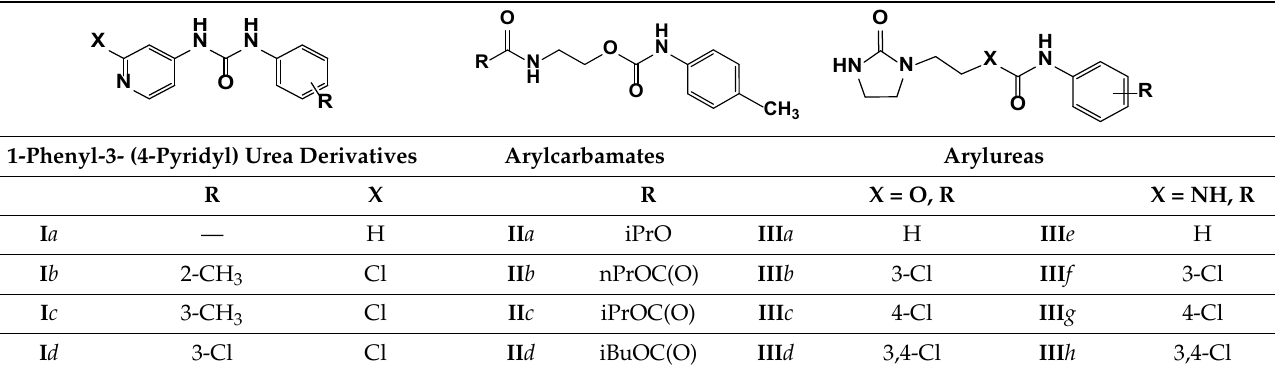
Table 1. Structural formulas of synthesized aryl carbamates and ureas.